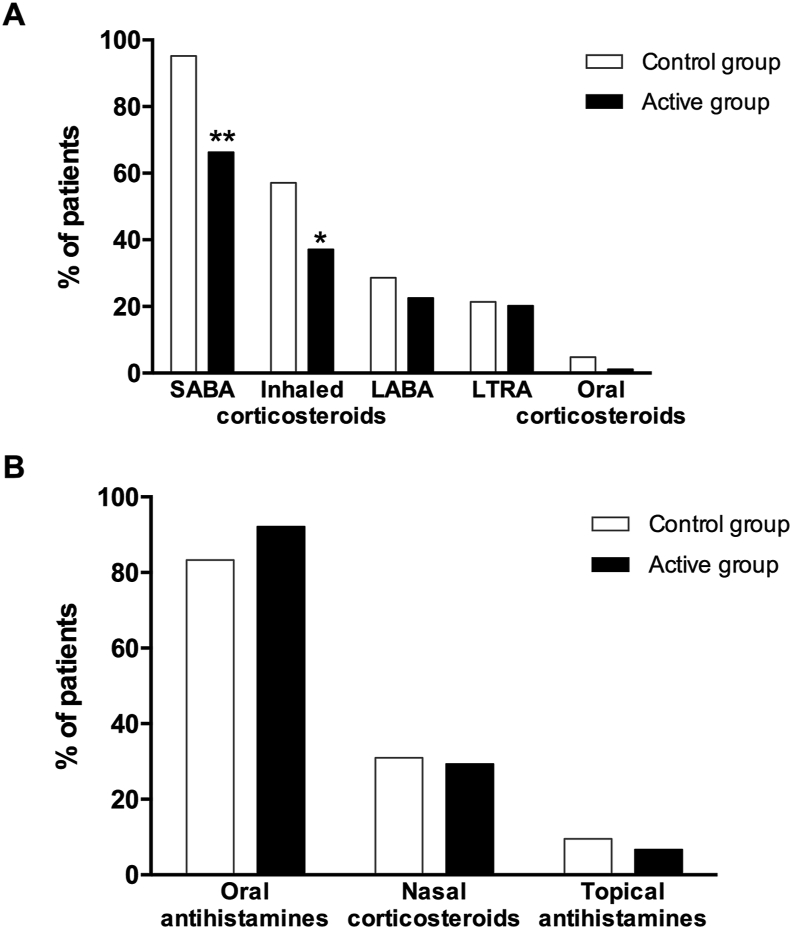
Use of medication to treat asthma (A) and rhinitis (B) in the active and control treatment groups. SABA, short-acting beta-agonist; LABA, long-acting beta-agonist; LTRA, leukotriene receptor antagonist. Chi-square test, ∗P < 0.05, ∗∗P < 0.01